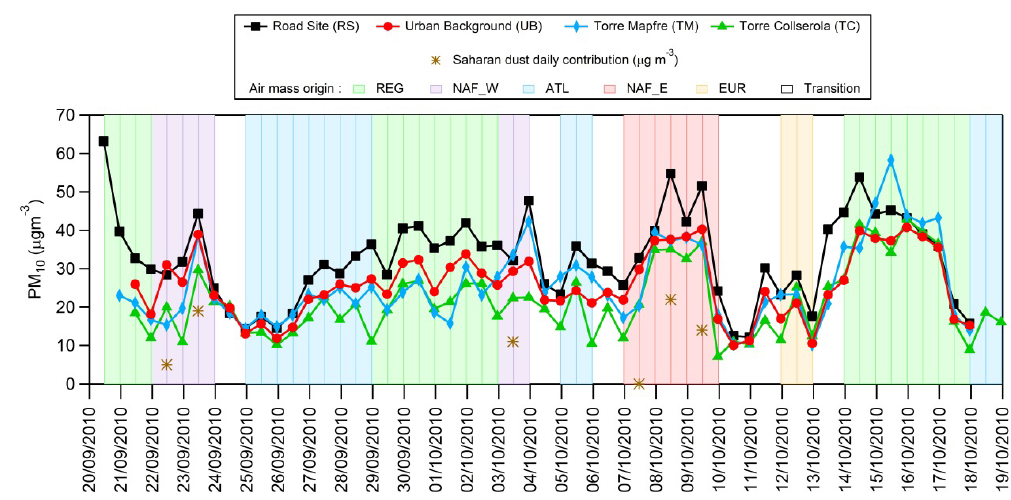
Figure 1. PM 10 variation at the four sites (RS, UB, TM, TC) during the SAPUSS campaign under different air mass origin (regional (REG), North African west (NAF_W), Atlantic (ATL), North African east (NAF_E), European (EUR)). Saharan dust daily contribution to PM 10 is